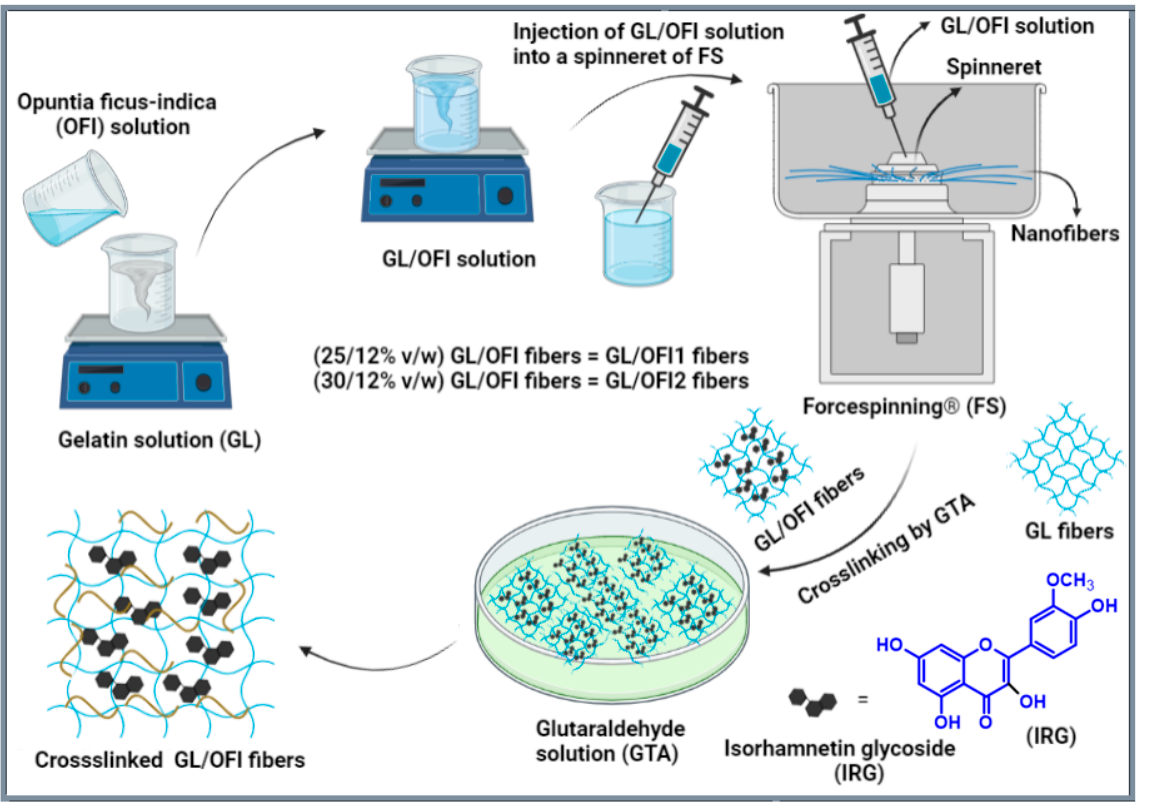
Figure 1. Schematic representation of the fabrication and crosslinking process of forcespun GL/OFI nanofibers.